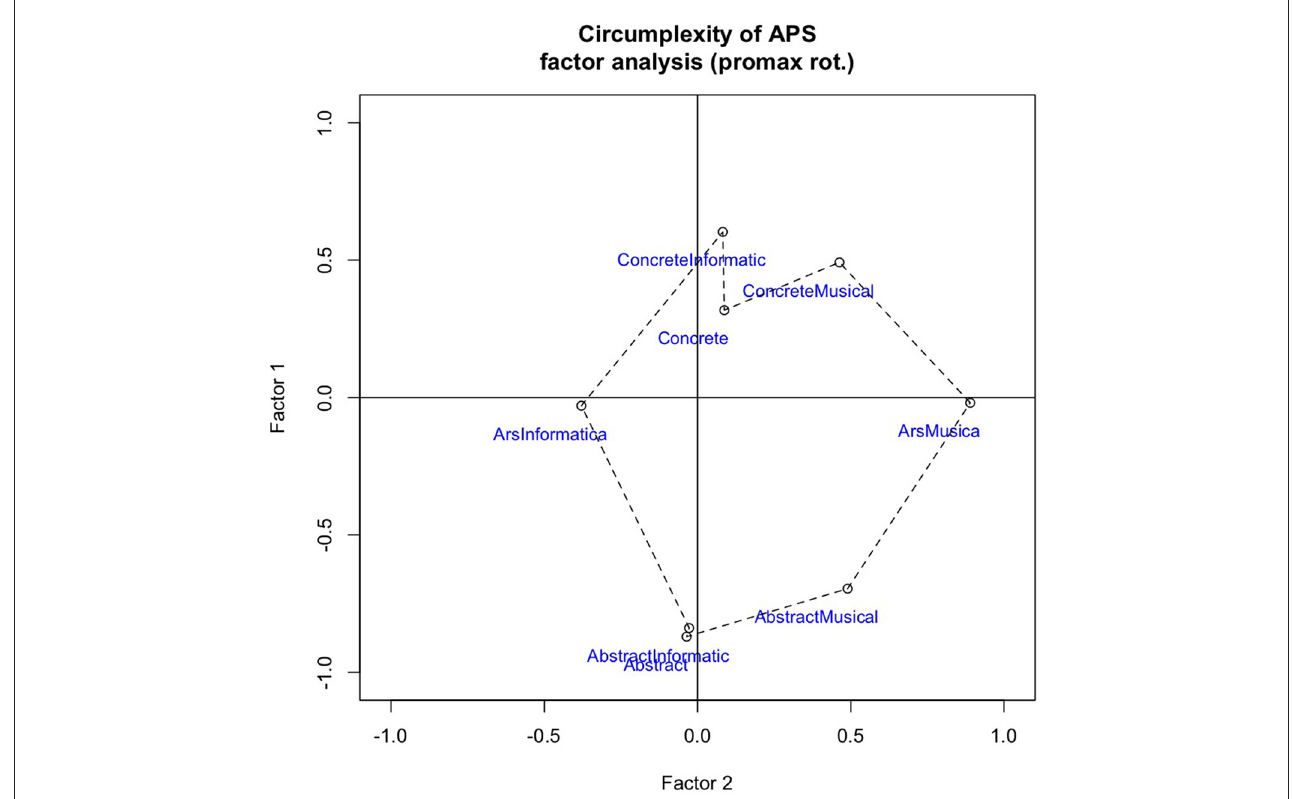
FIGURE3 Factor analysis plot to test the circumplexity of eight scales underpinning the Aesthetic Perspective Space.